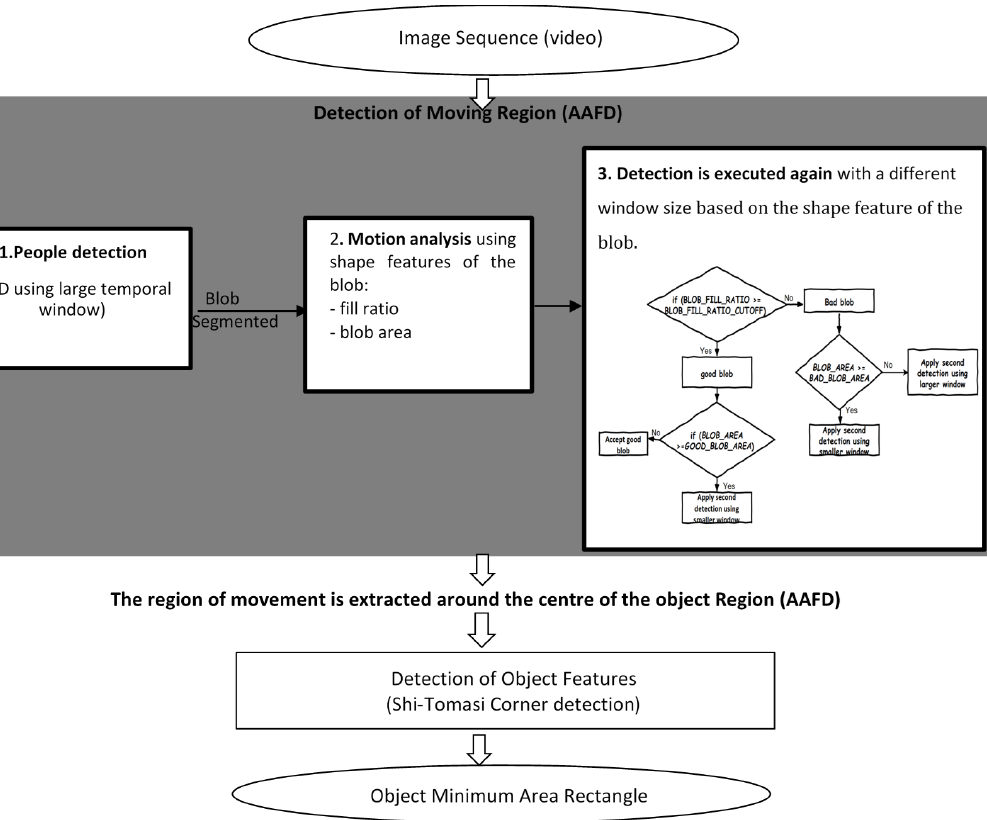
Figure 1. Block diagram of combination of Adaptive Accumulated Frame differencing (AAFD) and corner detector for people